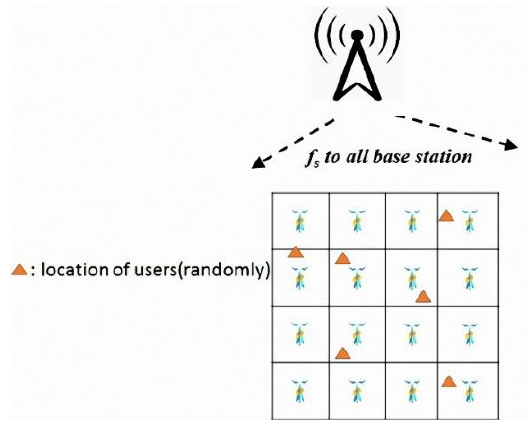
Figure 3. Locations of terrestrial station and users.